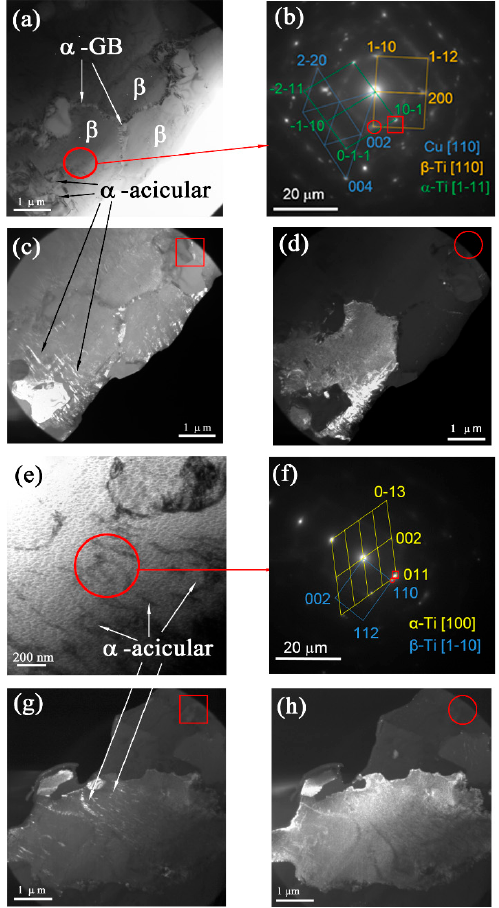
Figure 8. TEM bright- ( a , e ) and dark-field ( c,d,g,h ) images and SAED patterns ( b , f ) of the middle SZ2 part microstructures. Dark-field images ( c,d ) were obtained using reflections (10-1) α and (-110) β , respectively. Dark-field images ( g,h ) were obtained using reflections (011) α and (110) β , respectively. The middle SZ2 β grains contained fine acicular α -Ti grains, as could be observed from the TEM image in Figure 8c,e and corresponding SAED pattern in Figure 8f. The total content of copper within this area was about 33 at.%, which corresponded to that of the Ti 2 Cu IMCs (Figure 9).